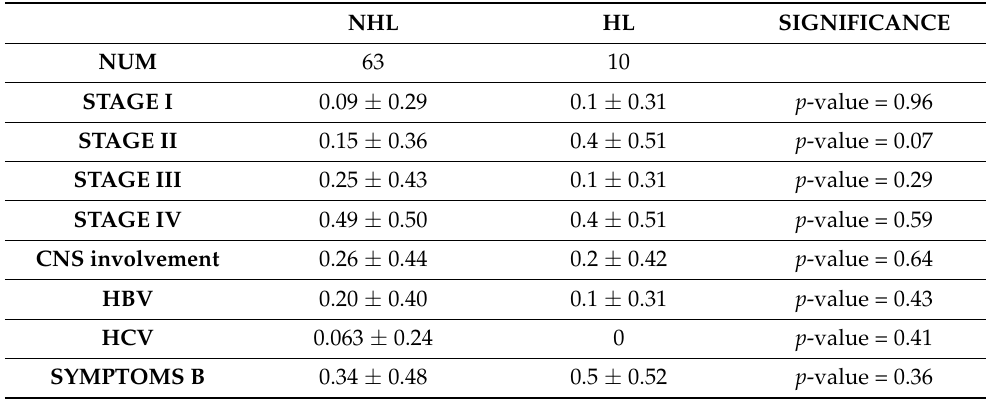
Table 2. Clinical parameters between the two groups of lymphoma patients (NHL and HL). Student’s t -test was applied unpaired between NHL vs. HL, p < 0.05 statistically significant.